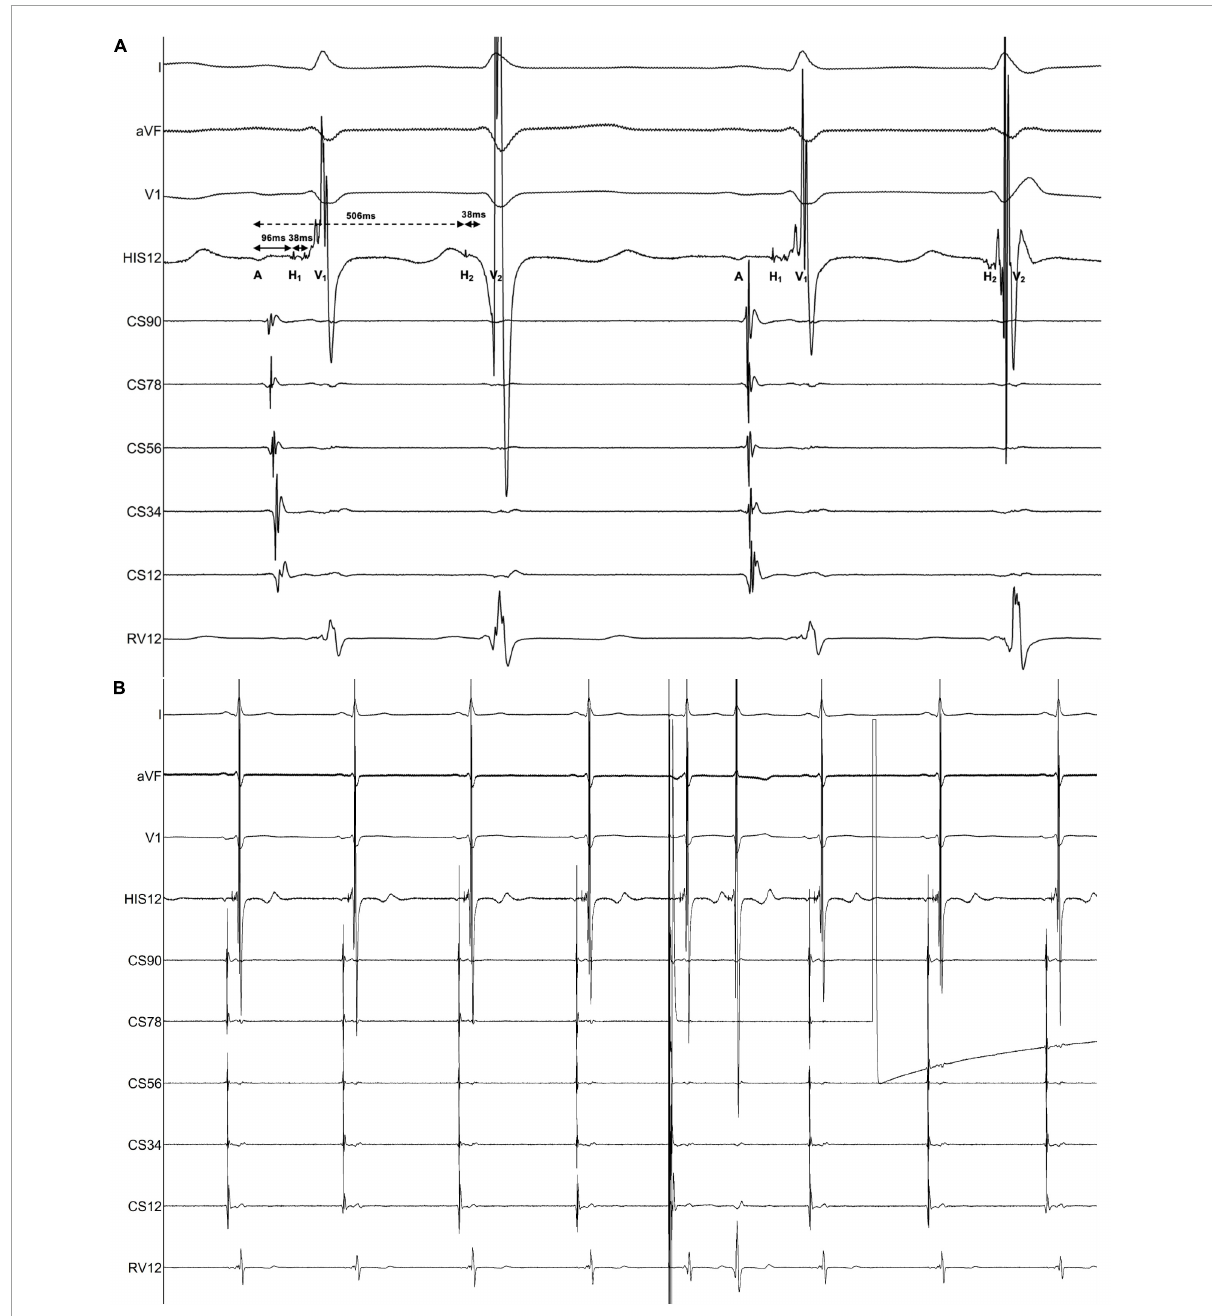
FIGURE4 Findings of the electrophysiological study. The intracardiac recording confirmed the diagnosis of dual AV nodal non-reentrant tachycardia (DAVNNT). (A) One atrial impulse (A) triggered one hissian potential (H 1 ) and one ventricular potential (V 1 ) through the fast pathway, and then one H 2 and one V 2 through the slow pathway. The time difference between the fast pathway with an AH interval of 96 msec and the slow pathway with an AH interval of 506 msec was long enough to result in a double ventricular response. The HV interval of both fast and slow pathways was 38 msec. This recording was taken at a sweep speed of 100 mm/s. (B) Atrial extra systolic stimulation can reproducibly induce a 1:2 conduction over the fast and slow pathways, corroborating the diagnosis of DAVNNT. A paper speed was 25